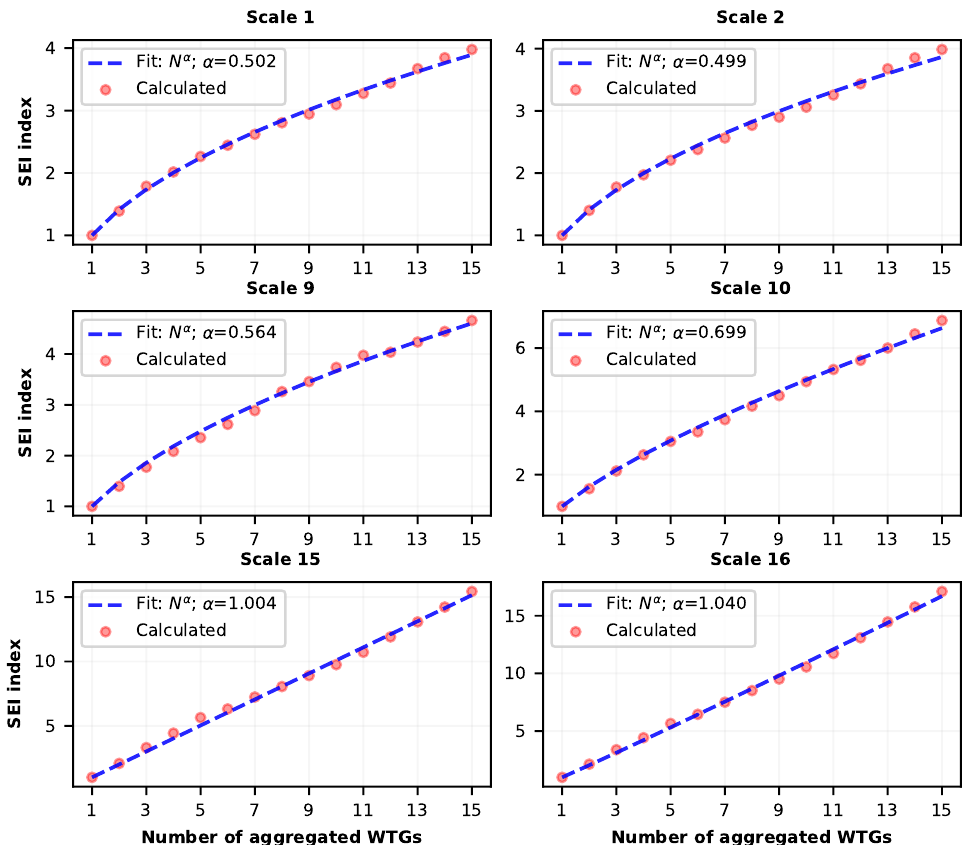
Figure 2. Smoothing effect index (SEI) as a function of number of aggregated WTGs in wind farm, observed at various frequency scales in wind farm. The observed values were fitted with a function N α , obtaining α at each scale.